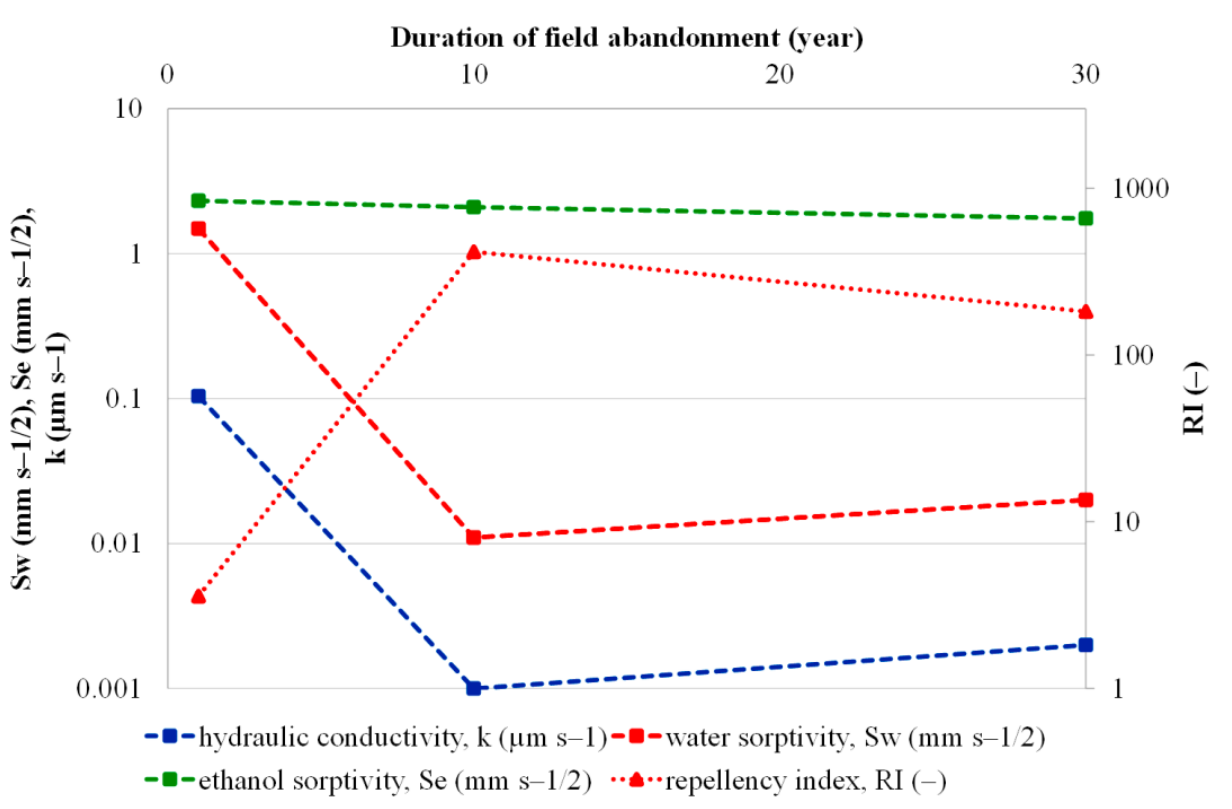
Figure 3. Relationships between soil organic carbon (SOC) content, pH (H 2 O), water drop penetra- tion time, WDPT, time to runoff, T , and surface runoff coefficient, C r , estimated in the top layer of acidic sandy soils, and duration of field abandonment at experimental sites S1, S2, and S3 located at Studienka village in the Borská nížina lowland (southwestern Slovakia). Note that both vertic al axes have a logarithmic scale.